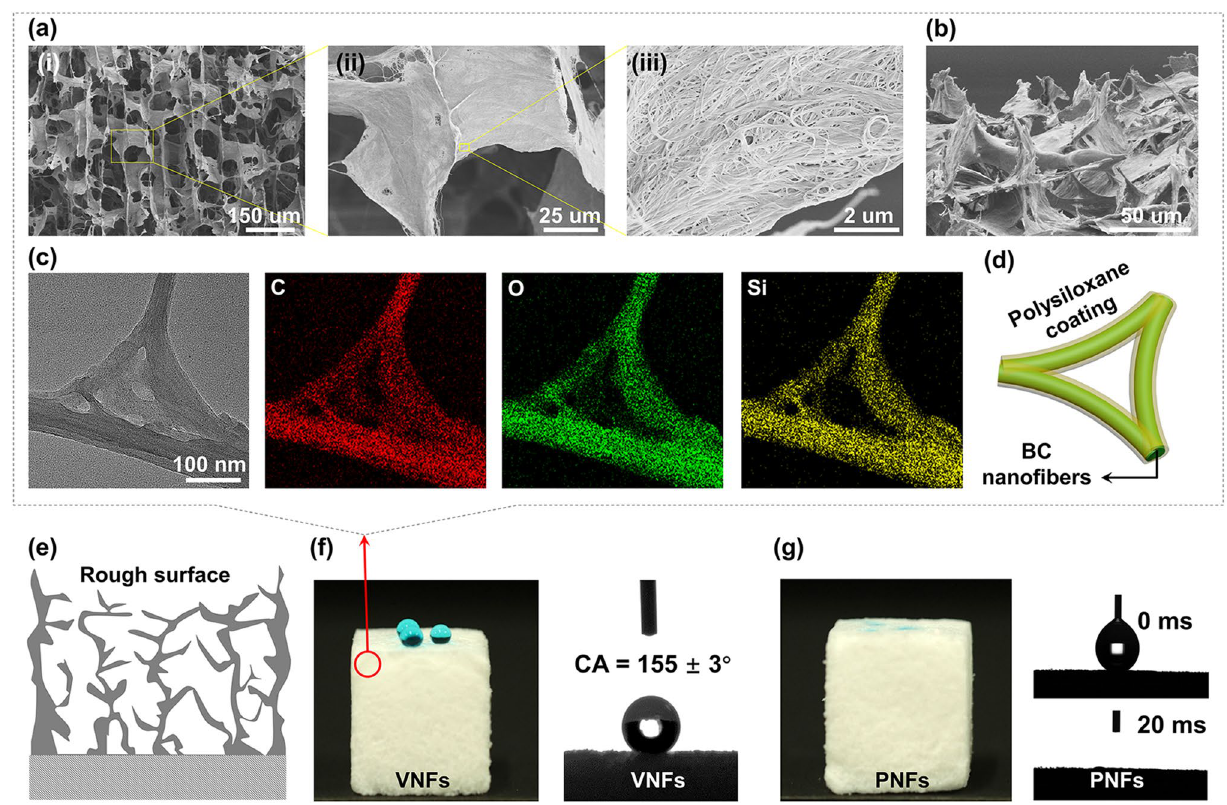
Fig. 2 Microstructure and surface wettability of hybrid aerogels. a Microscopic structure of VNFs observed by SEM at different magnifications. b Side-view SEM image of superhydrophobic VNFs nanostructure. c STEM-EDS mapping of BC-PVSQ nanofibers with elements of C, O, and Si, respectively. d Schematic illustration of polysiloxane-coated BC nanofibers. e Surface roughness of the aerogels (VNFs and PNFs) with numerous nanoscale fibrous protrusions. f Digital photo of water drops on the surface of VNFs and corresponding contact angle measurements. g Digital photo of water absorbed on the surface of PNFs and corresponding contact angle